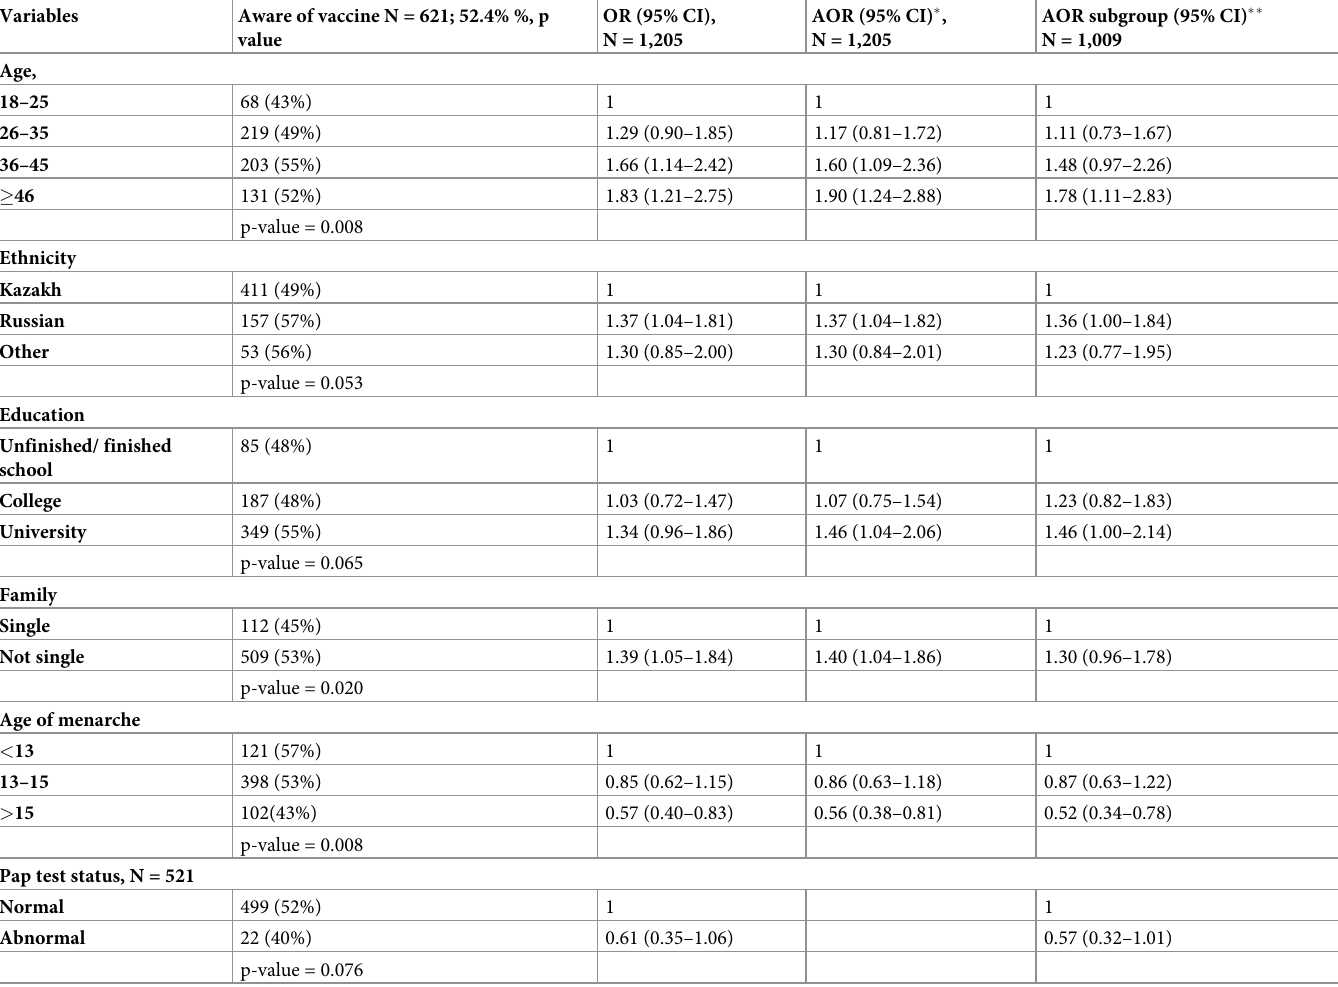
Table 4. Awareness of HPV vaccination among women visiting gynecological clinics, (N = 1,205).